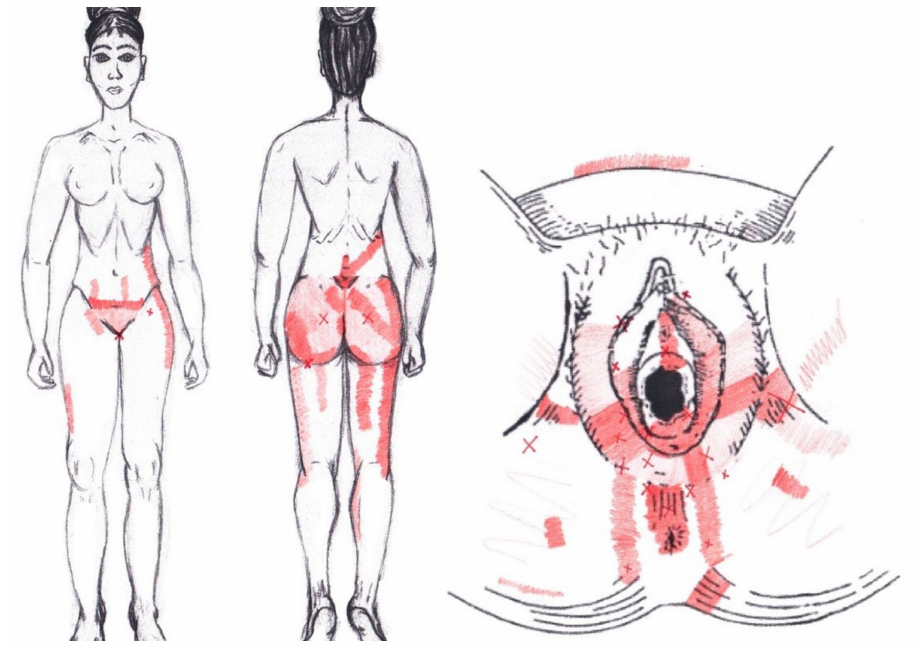
Figure 21. Graphical simulation of referred pain areas of the piriformis